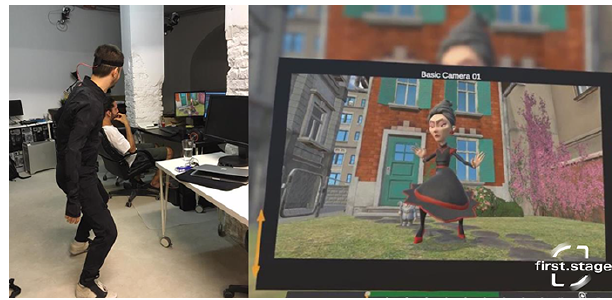
Figure 20. A performer directly animating the character using the Rokoko Smartsuit.